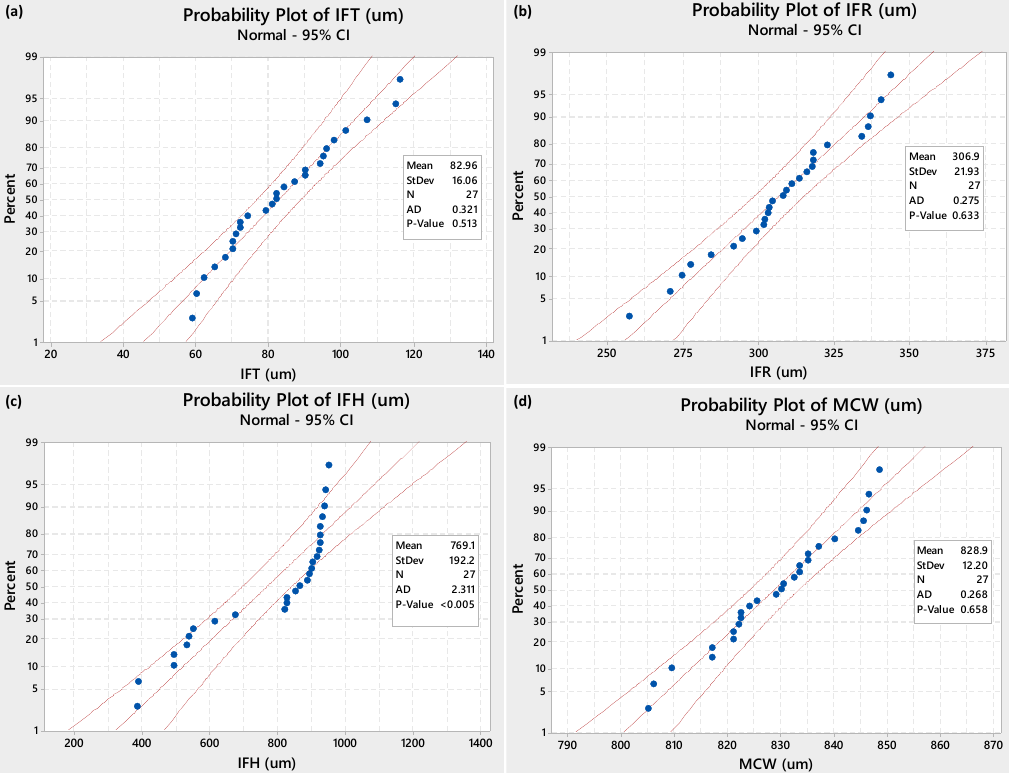
Figure 3. Probability plots of data points associated with: ( a ) inter-channels fin thickness (IFT), ( b ) inter-channels fin radius (IFR), ( c ) inter-channels fin height (IFH), and ( d ) micro-channels width (MCW).